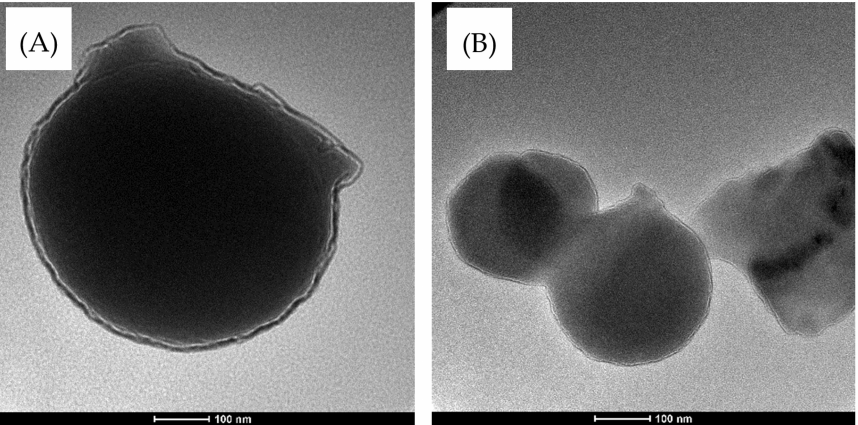
Figure 5. TEM of ( A ) S. lutetiensis and ( B ) L. plantarum showing the shape of the cells and the thickness of the cell